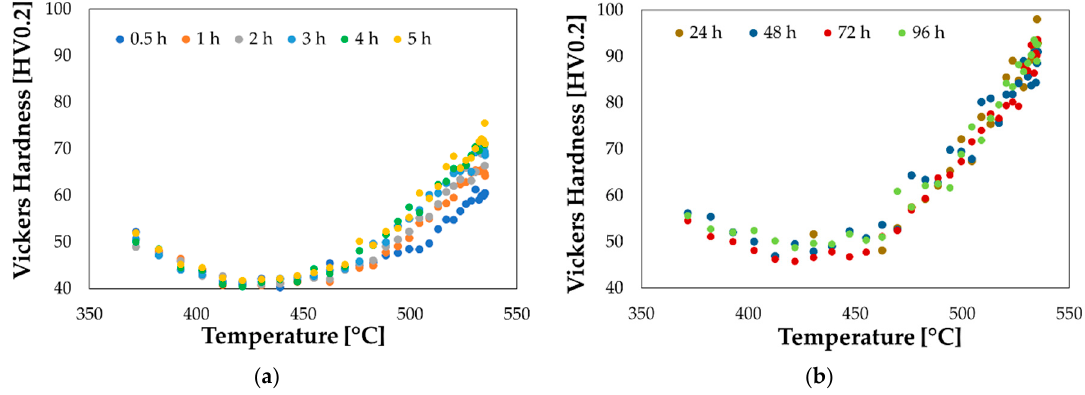
Figure 8. Evolution of the natural ageing phenomena: ( a ) from 0.5 h to 5 h; ( b ) from 1 to 4 days.